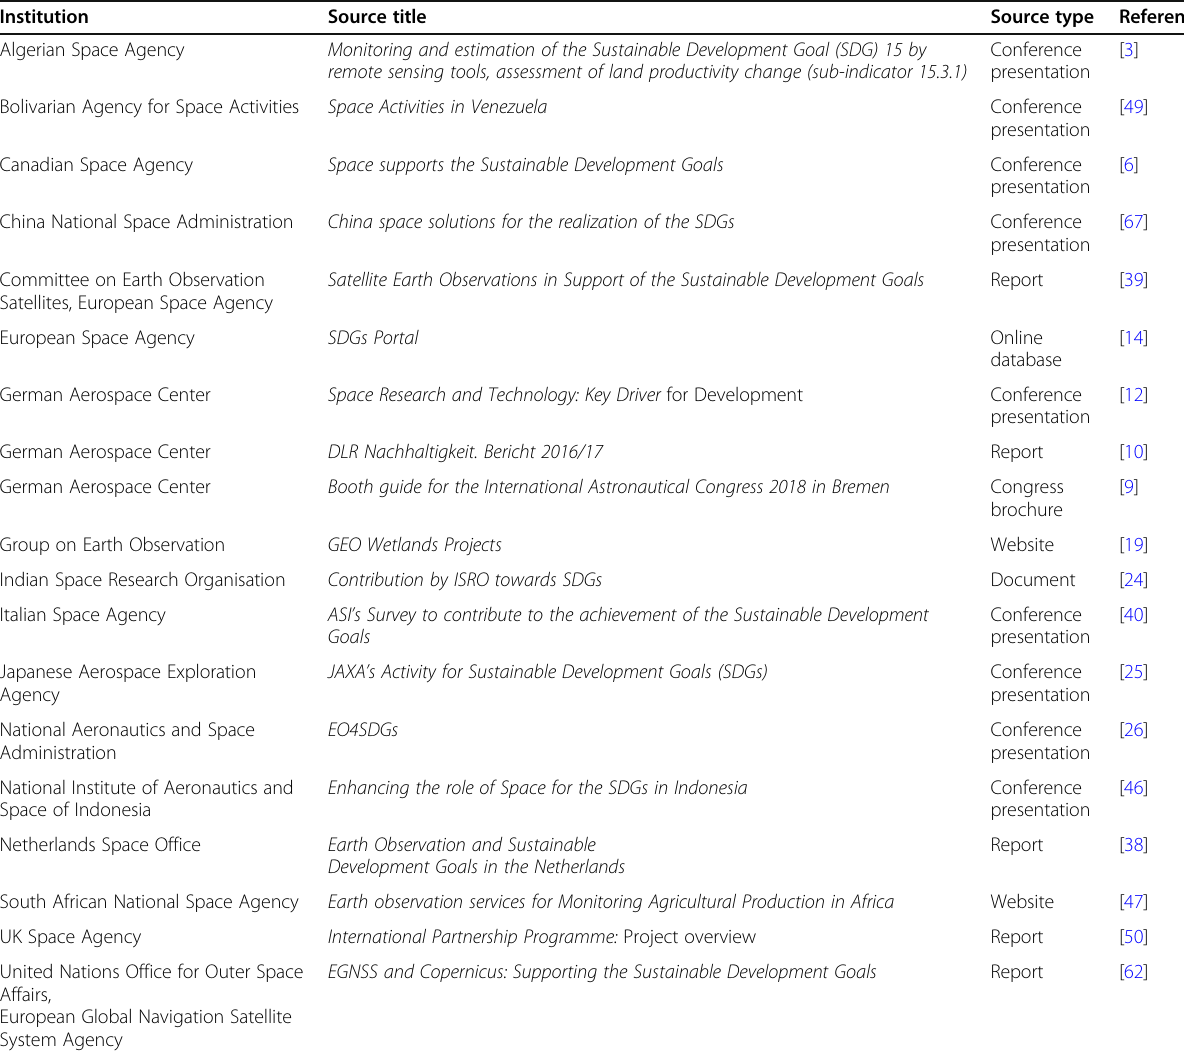
Table 1 List of sources utilised for the mapping of space-related contributions to the SDGs